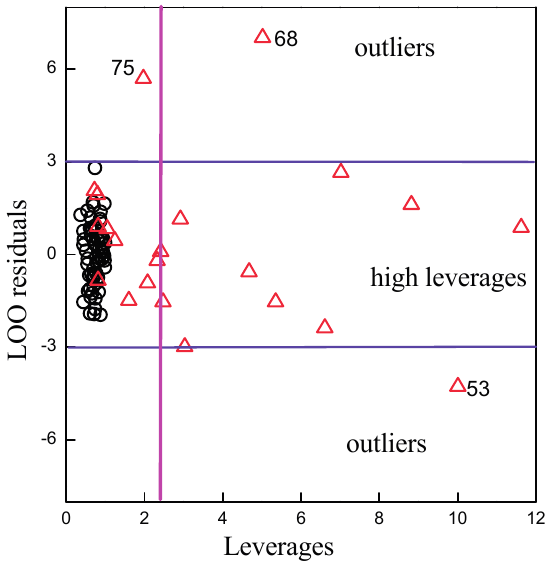
Figure 2. Willam’s maps for model’s application domain. Plot of the LOO standardized residuals versus leverage of the PLS model. The small black circles represent samples of the training set, and the red up-triangle on behalf of the samples in test